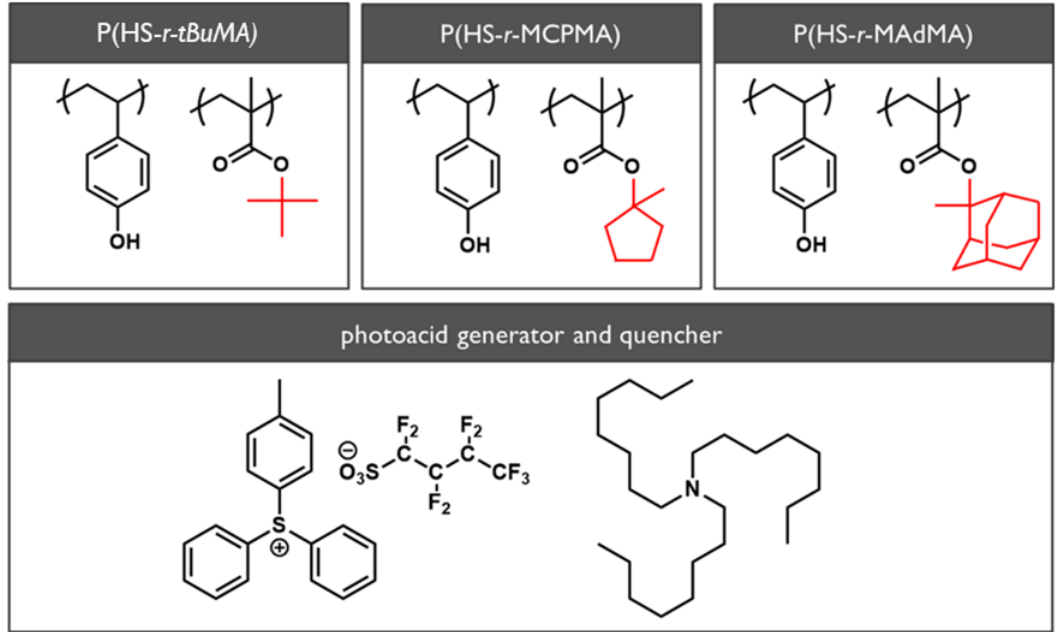
Figure 1. The chemical structure of the poly(hydroxystyrene- ran -tert-butyl methacrylate) (P(HS- r -tBuMA)), poly(hydroxystyrene- ran -1-methylcyclopentyl methacrylate) (P(HS- r -MCPMA)), and poly(hydroxystyrene- ran -1-methyladamantyl methacrylate) (P(HS- r -MAdMA)) polymers, and associated photoacid generator ((4-methylphenyl)diphenylsulfonium nonaflate) and quencher (trioctylamine) used in the full resist formulation.